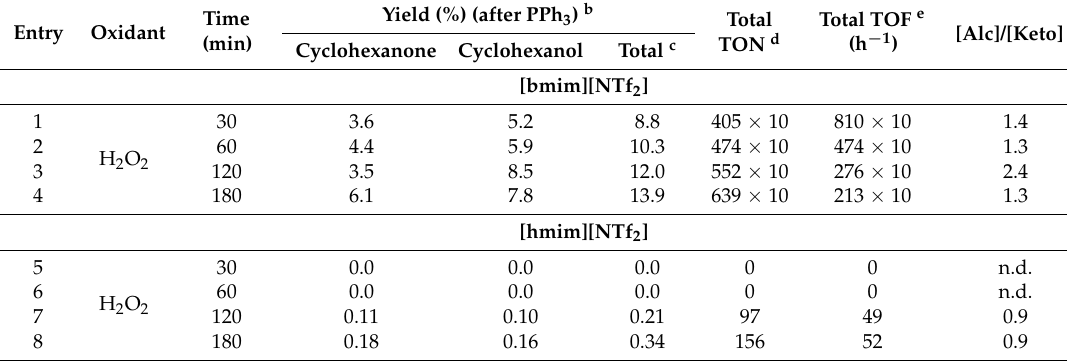
Table 3. Oxidation of cyclohexane to cyclohexanol and cyclohexanone catalysed by 1 a in an